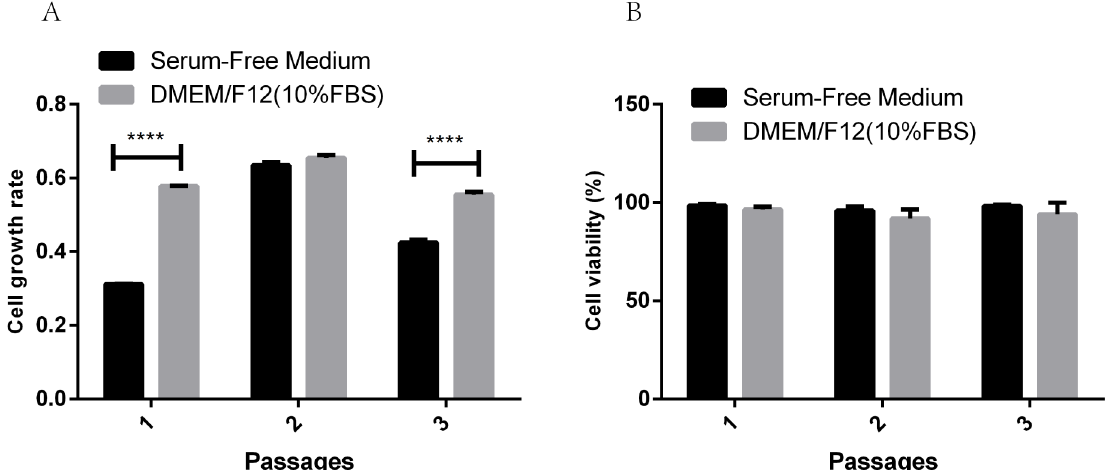
Fig 7. Verification of culture effect of serum-free medium. (A) The growth rates of PC-3 cells in the control groups and in the optimizedgroups. (B) The viabilityof PC-3 cells in the control groupsand in the optimizedgroups. serum as the control in triplicate. As shown in Fig 7, the growth rates of PC-3 cells were 0.58, 0.65 and 0.55, respectively, in the control groups, while the growth rates of PC-3 cells were 0.31, 0.63 and 0.42, respectively, in the optimized groups. In addition, the viability of PC-3 cells in the control groups were 96.58%, 91.23% and 94.34%, while the viability of PC-3 cells in the optimized groups were 98.53%, 95.73% and 98.31%. Data were presented as mean ± SD. (cid:3)(cid:3)(cid:3)(cid:3) meant p < 0.0001.